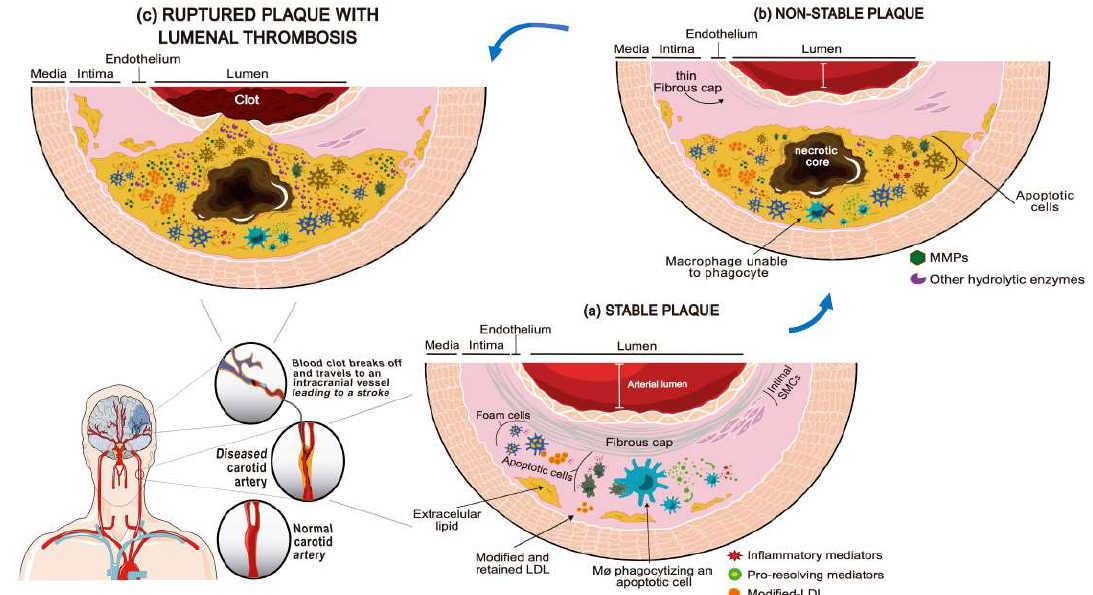
Figure 1. Progression of carotid plaque leading to ischemic stroke. Atherosclerosis in the carotid artery is the main cause of atherothrombotic ischemic stroke. Atherosclerosis may develop for years without symptoms for as long as the plaque remains stable. ( a ) When the mechanisms counteracting inflammation are overwhelmed, the balance to inflammatory processes is favored, leading to necrosis and release of inflammatory mediators and proteolytic enzymes that degrade the fibrous cap. The plaque then becomes unstable. ( b ) The unstable atherosclerotic plaques may break and then coagulation is triggered, eventually leading to thrombosis and brain ischemic events ( c